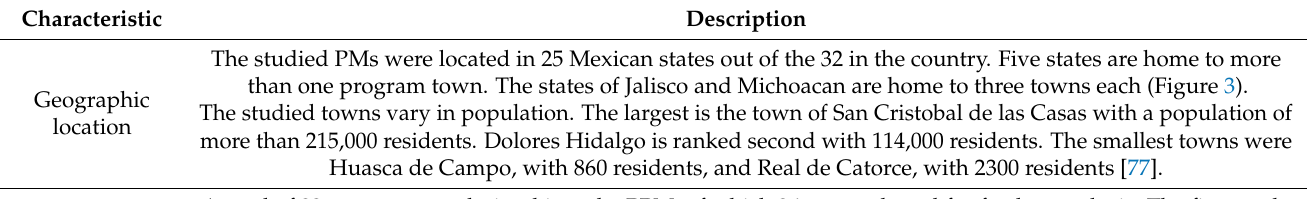
Table 1. Description of the studied PMs.